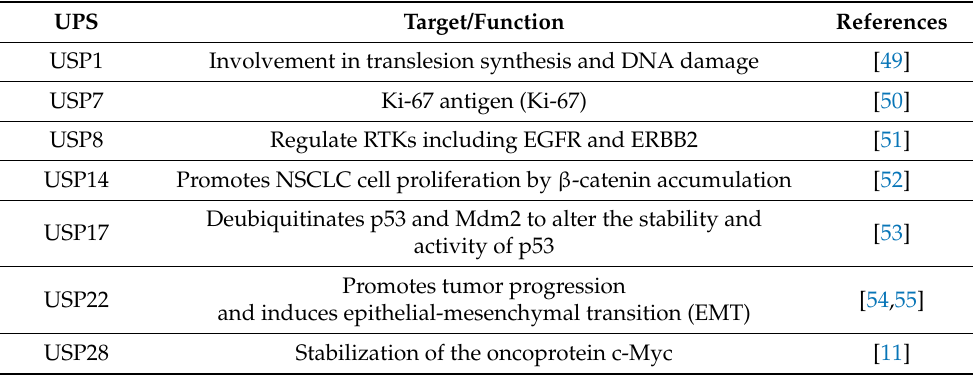
Table 2. Representative DUBs and their associations with lung